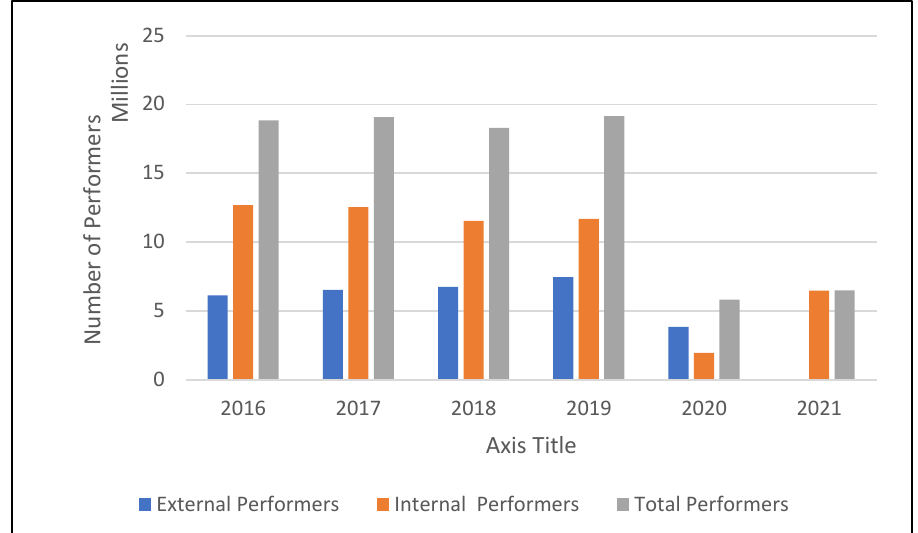
Figure 1. The Numeric Distribution of the Total Number of Umrah Performers. Source: General Authority for Statistics Kingdom of Saudi Arabia [4].